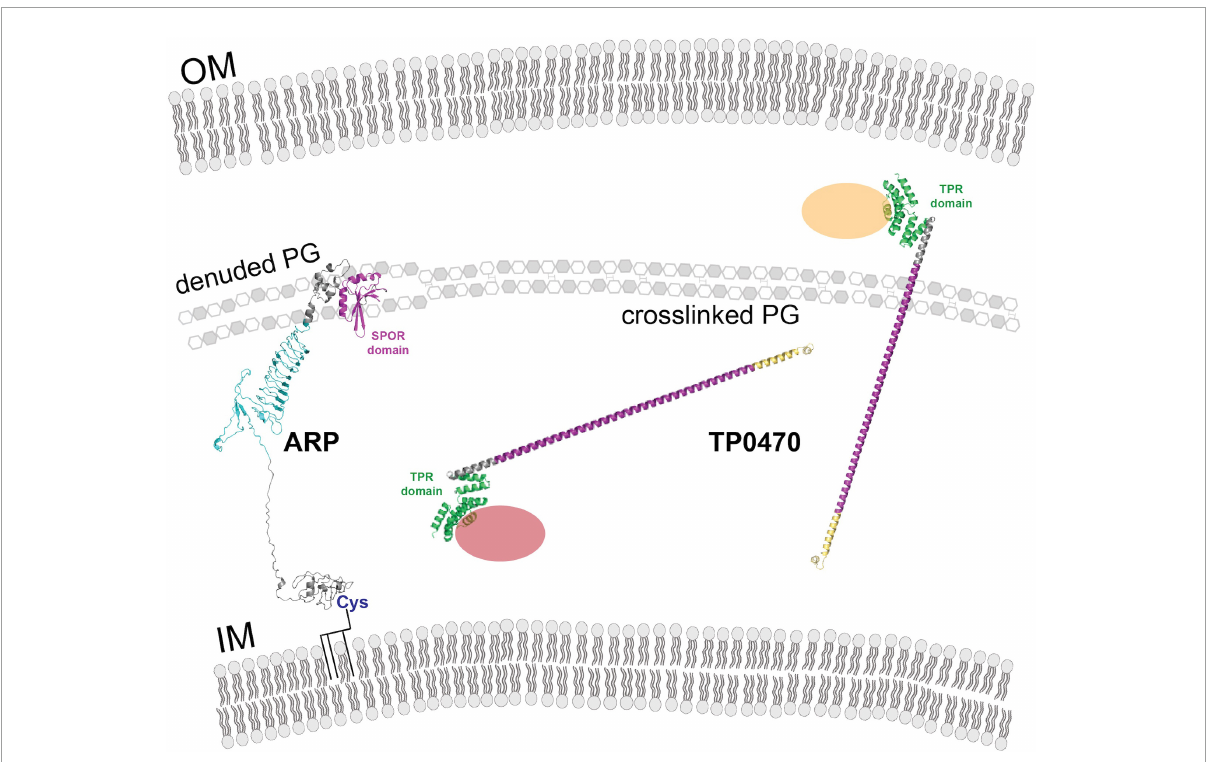
FIGURE6 Model showing ARP and TP0470 cellular location and putative interactions. Both ARP and TP0470 are localized to the periplasm. The ARP N terminus may be acylated at cysteine 29. OM, outer membrane; IM, inner membrane; PG, peptidoglycan. Proteins and cellular structures have not been drawn to